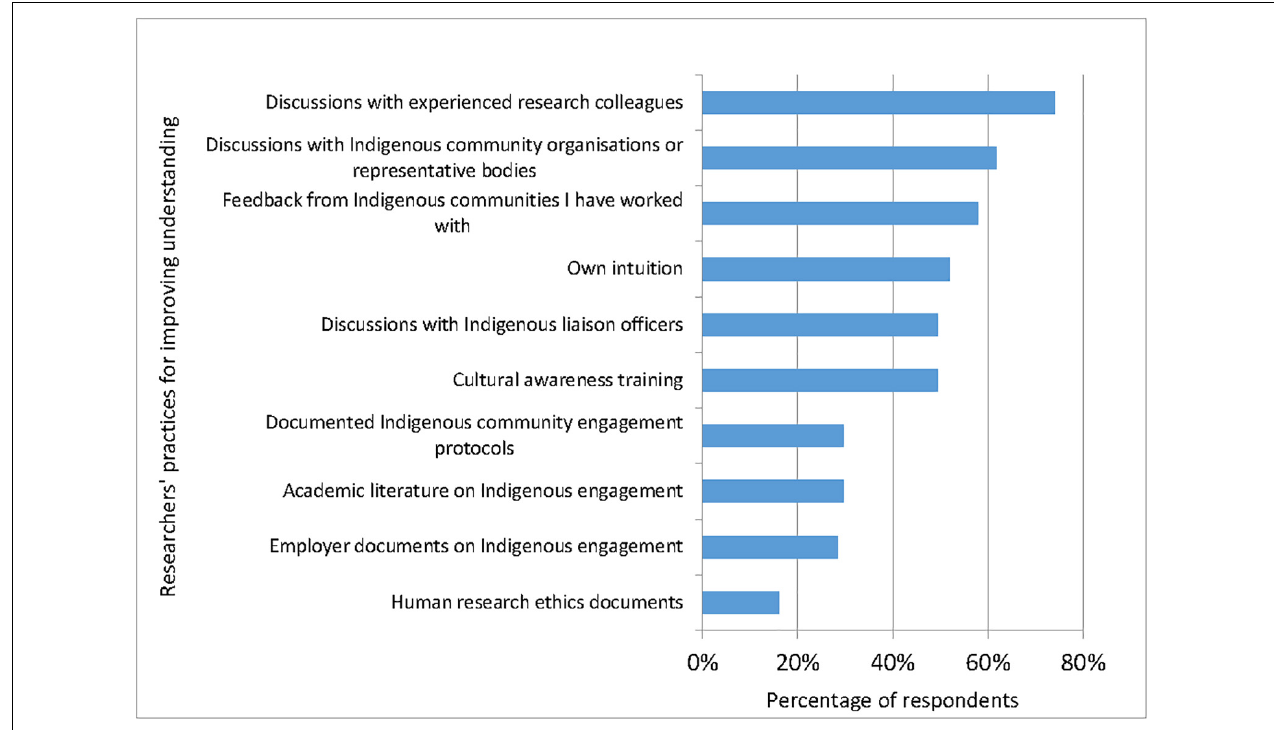
FIGURE 5 | Researchers’ practices for developing understanding of engagement with Aboriginal and Torres Strait Islander people measured as a percentage of survey respondents ( n = 81).